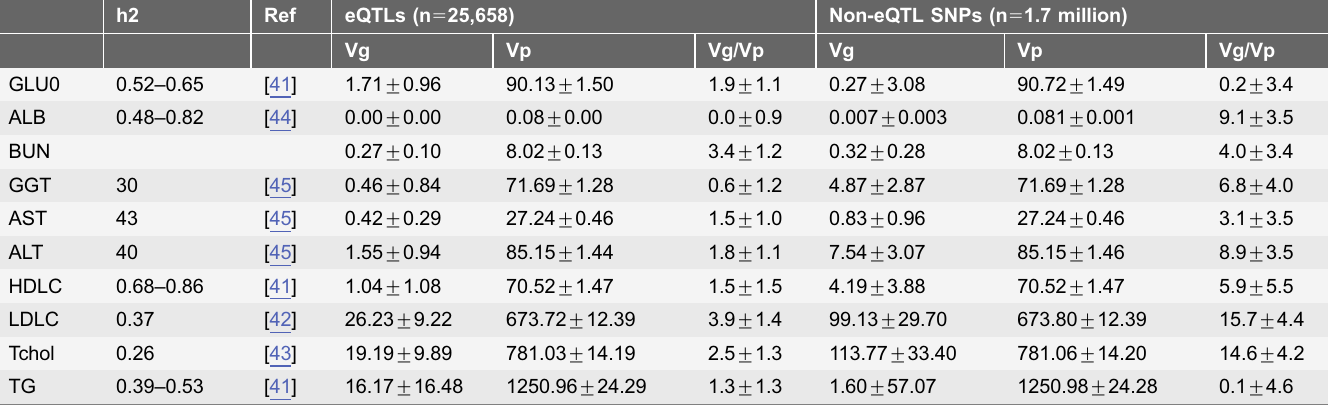
Table 2. Estimated genetic variance explained by eQTL SNPs and non-eQTL